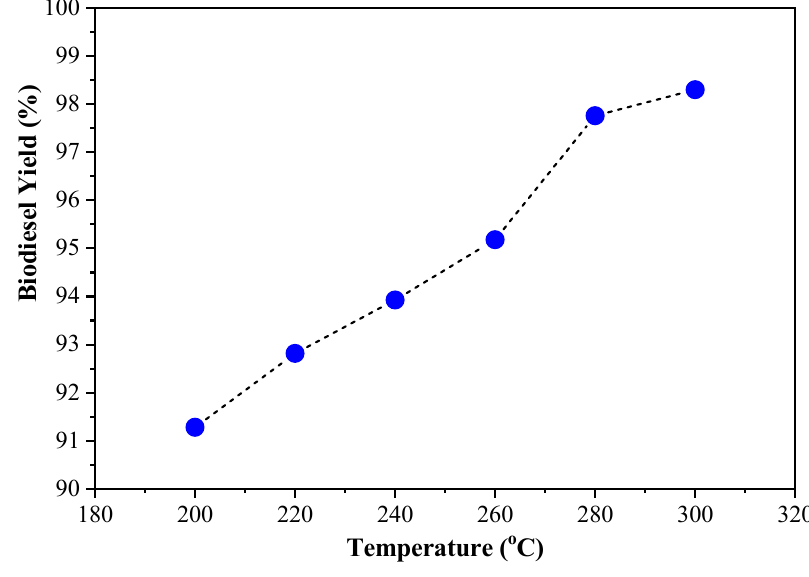
Figure 6. E ff ect of temperature on biodiesel